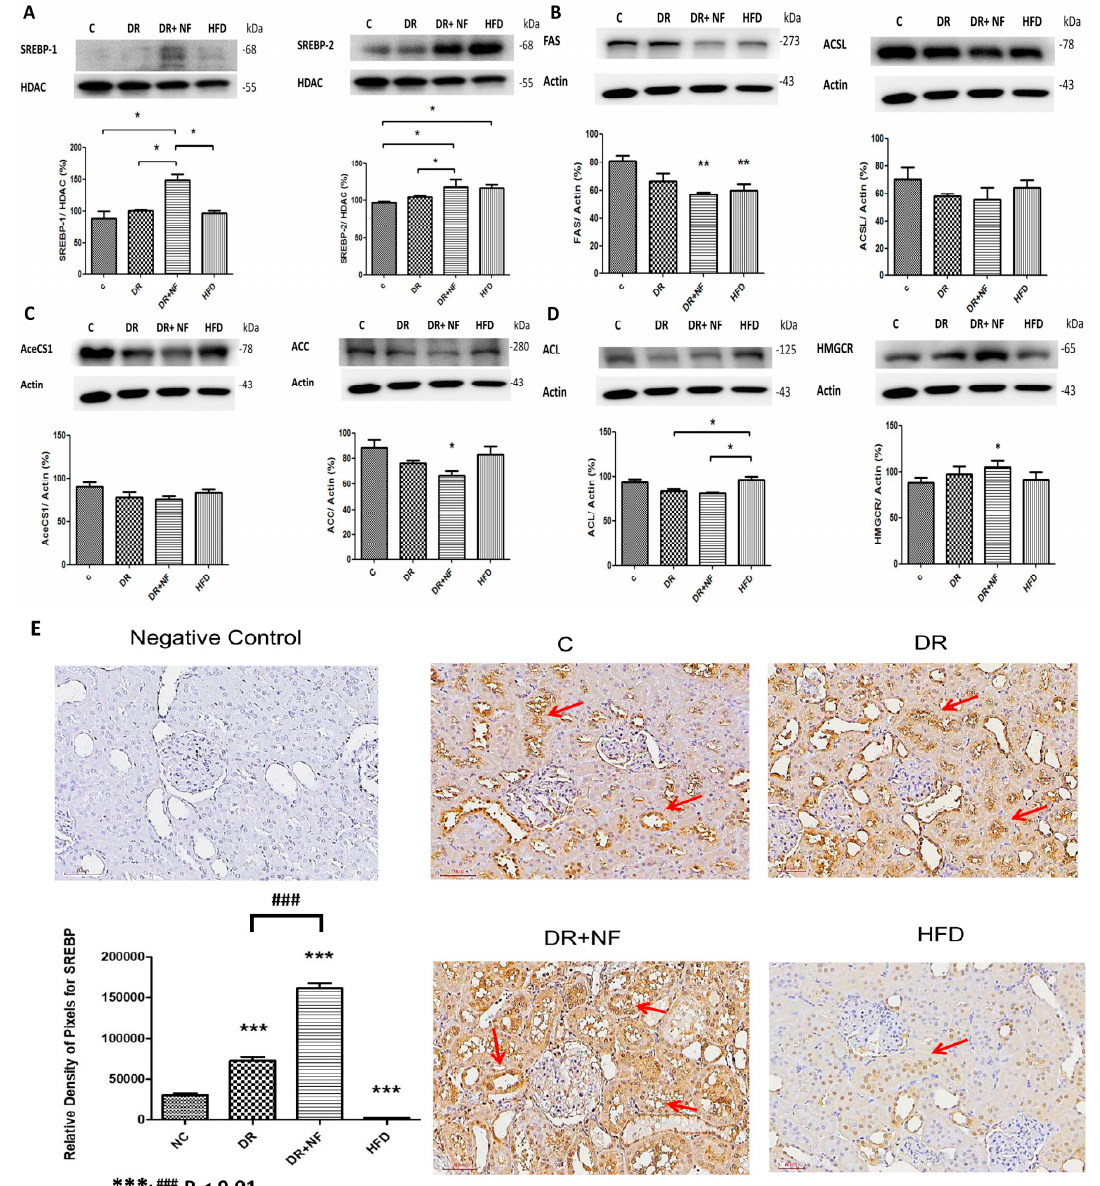
Figure 5. Sterol regulatory element-binding protein (SREBP)-1 / 2 transcriptional factor and related enzymes in rats. ( n = 3) ( A ) In renal tissue, western blotting showed that SREBP-1 / 2 was significantly increased in the DR + NF group compared to the DR group and the control (* p < 0.05). ( B ) Fatty acid synthase (FAS) (actin as control) showed lower expression in the DR, DR + NF, and HFD groups compared to the control group (** p < 0.01). ( C ) Acetyl-CoA carboxylase (ACC) (actin as control) was decreased in the DR + NF group compared to the control (* p < 0.05). ( D ) The HFD group showed considerably higher ACL expression compared to the control group, and the expression of HMGCR was also significant in the DR + NF group relative to the control (* p < 0.05). ( E ) The immunohistochemical expression and quantification of SREBP (red arrow) in the rat renal tubule was increased significantly in the DR and DR + NF groups compared to the control. DR + NF was more prominently enhanced than DR only ( ### p < 0.01, *** p < 0.01). However, expression of SREBP was decreased in the HFD group (magnification 200 ×).